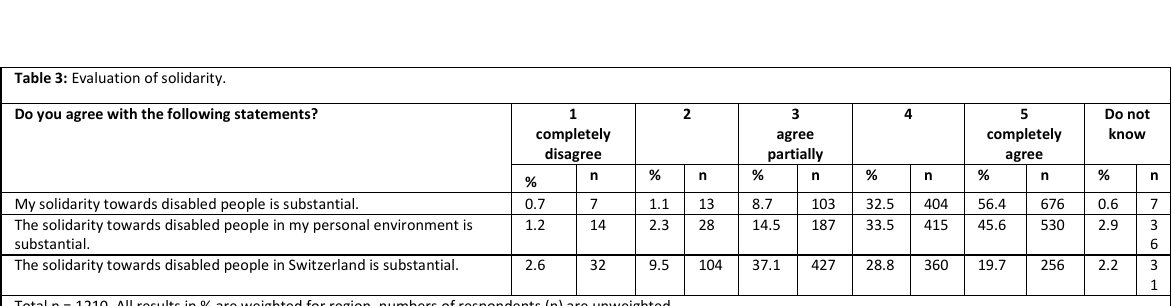
The solidarity towards disabled people in Switzerland is